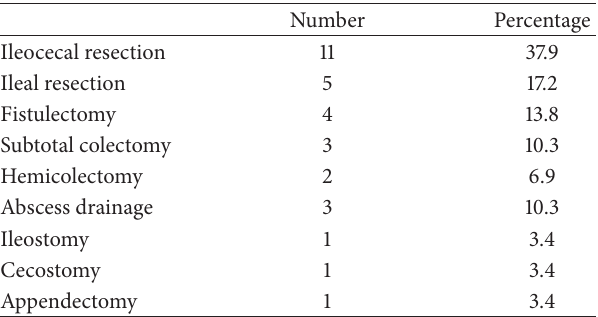
Table 4: Surgical procedures ( 𝑛 = 31 ) performed for 29 Crohn’s patients with